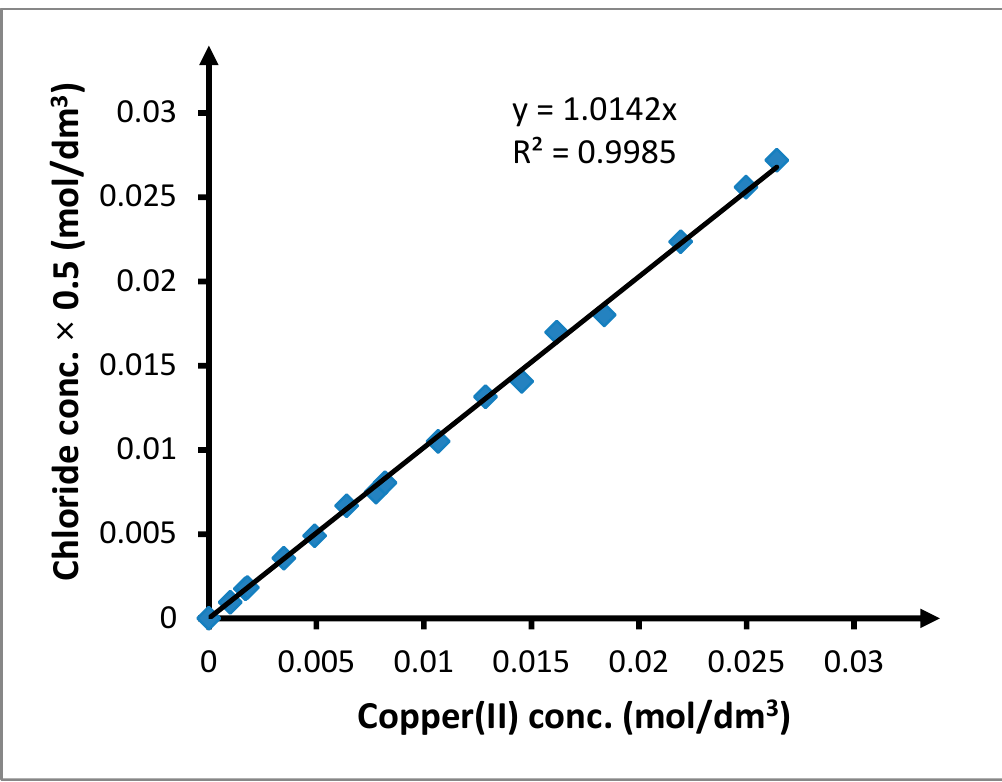
Figure 5. Relationship between chloride anion concentration and copper(II) concentration in receiving phase. The volumetric flow rate was 3.0 cm 3 / min. Feed phase: CuCl 2 concentration = 0.1 mol / dm 3 , chloride concentration = 2.0 mol / dm 3 ; receiving phase: demineralized water; and membrane: CTA-ONPOE-TRIA-10. The composition of the membrane is given in Table 2. Temperature: 20 ± 0.5 °C. All points representing the concentration of chloride anions lie on the straight line y = a + bx .